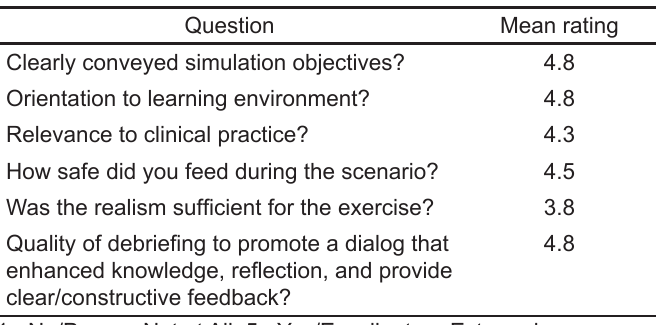
Table 5. Anonymous participant scenario feedback on a scale of 1 (poor) to 5